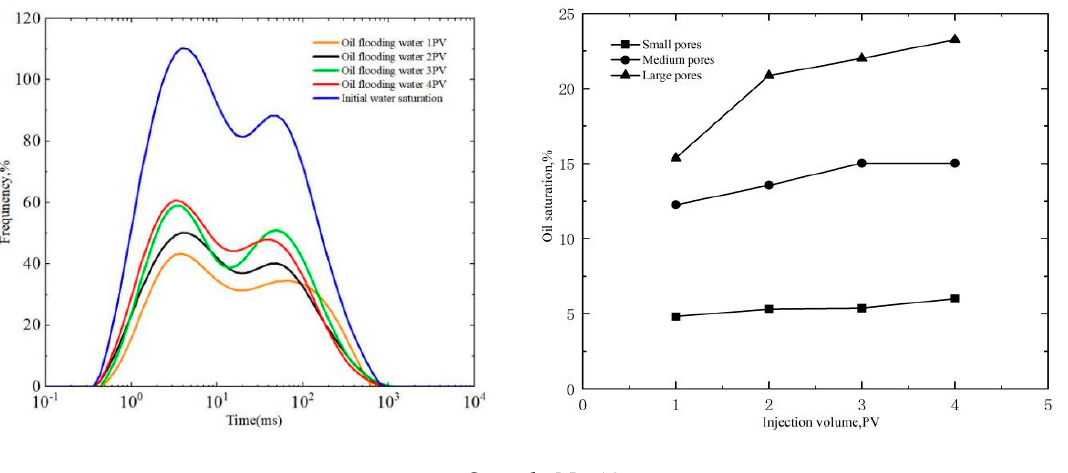
Figure 8. T 2 spectrum distribution of representative cores of Type III in the charging process and changes in oil saturation in different pores. changes in oil saturation in different